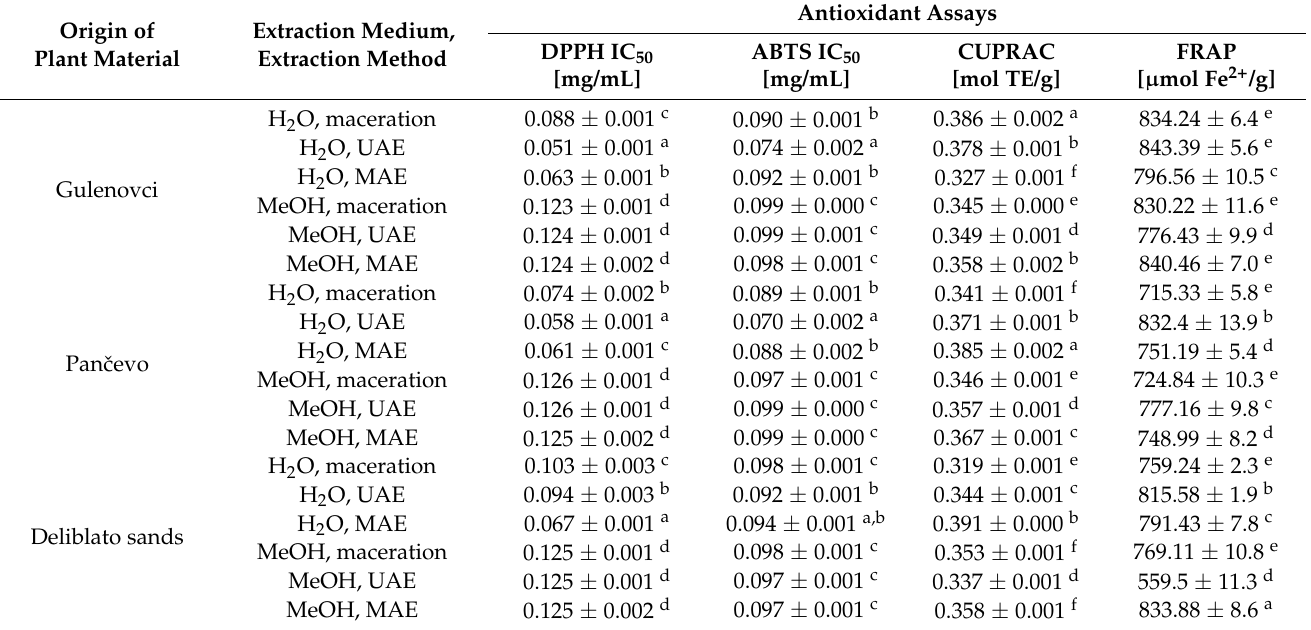
Table 2. Antioxidant (DPPH, ABTS, CUPRAC, and FRAP) activity of water and methyl alcohol extracts of the petals of Paeonia tenuifolia